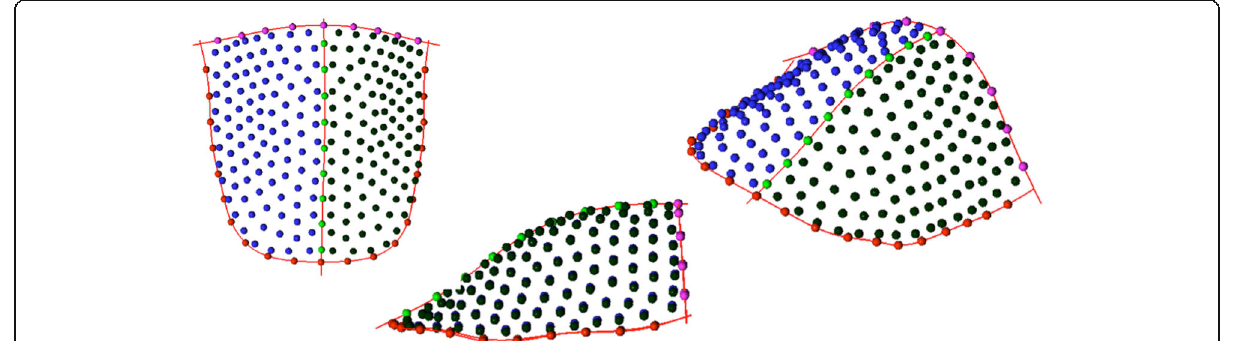
Fig. 1 The template of 240 landmarks and semi-landmarks used to study the palatal